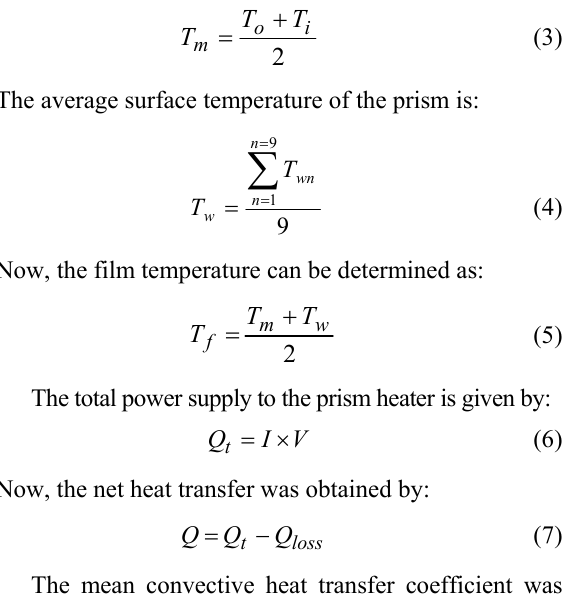
Figure 3. Thermocouples distribution around the prism [34] The porosity ((cid:31)) was evaluated by measuring the